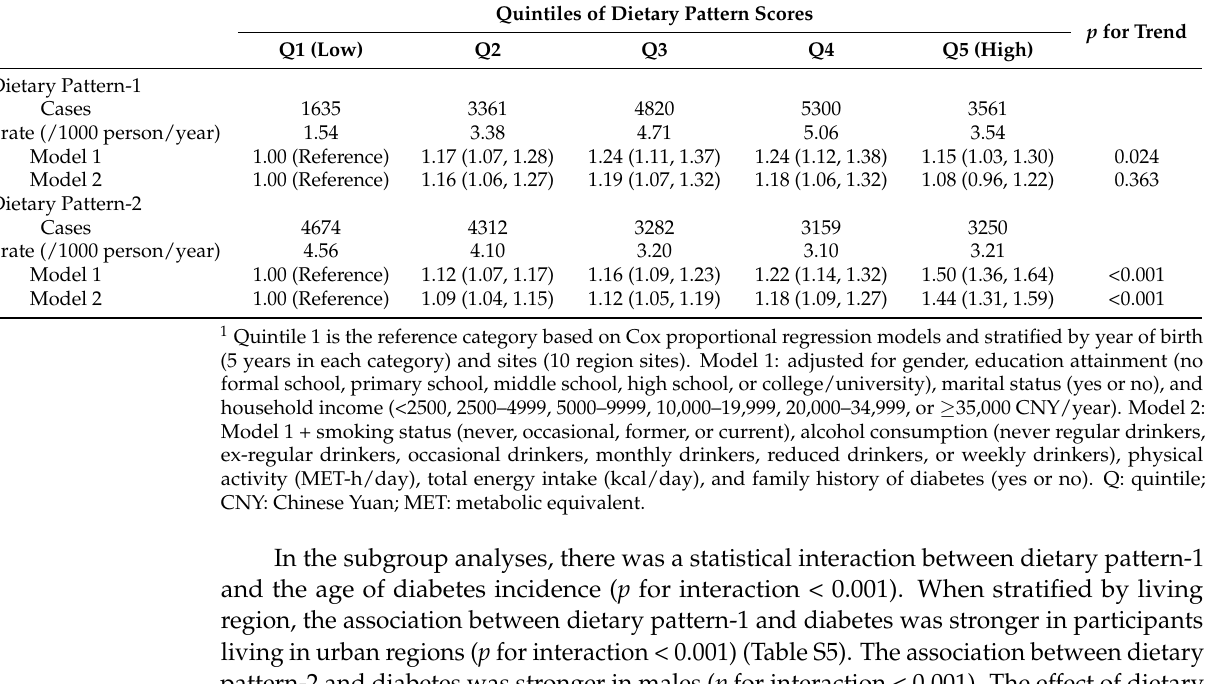
Table 3. Hazard ratios (HRs) and 95% confidence intervals (CIs) of diabetes incidence according to the quintiles of the dietary pattern scores of participants in the China Kadoorie Biobank ( n = 479,207) 1 . Quintiles of Dietary Pattern Scores p for Trend Q1 (Low) Q2 Q3 Q4 Q5